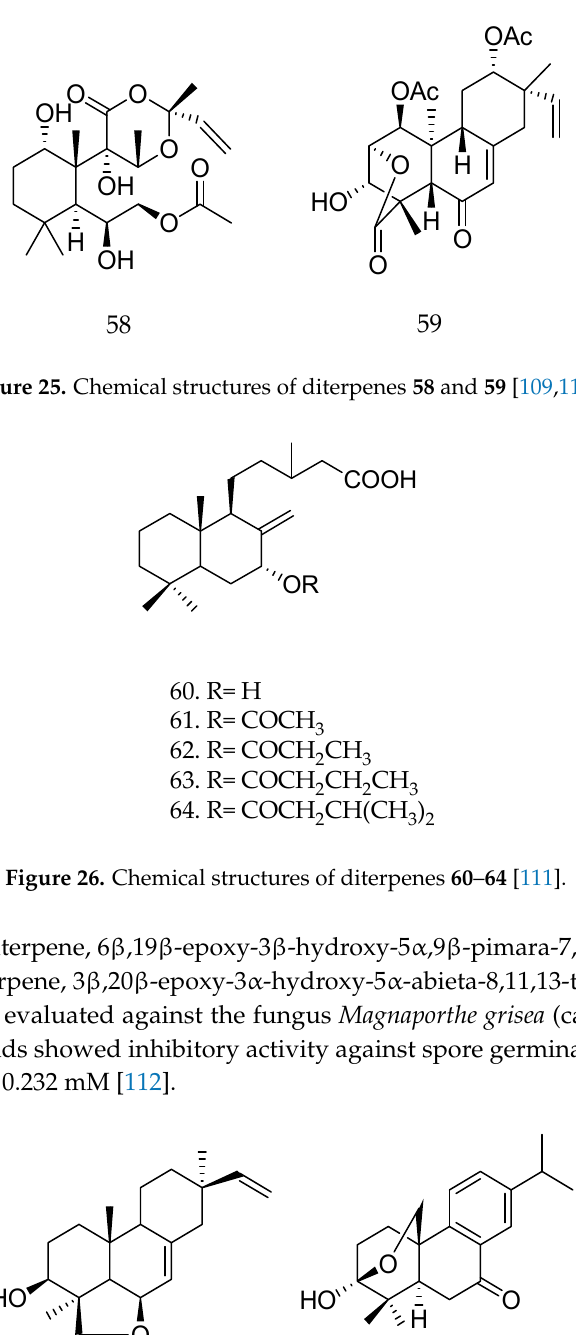
Figure 24. Chemical structures of diterpenes 56 and 57 [108].